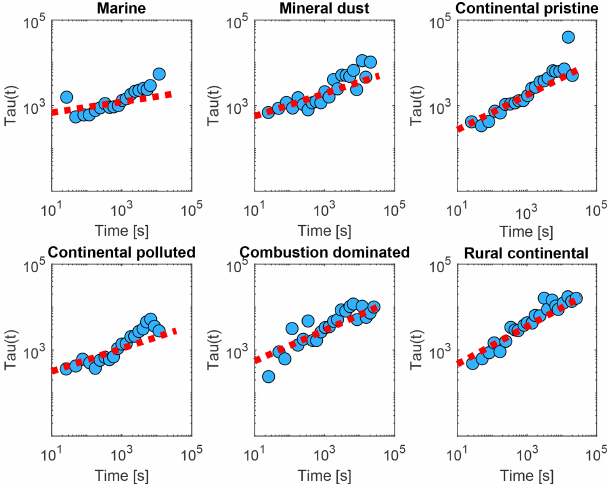
Figure 12. The relaxation time τ inferred from the isothermal experiments (up to 10h) using the averaged data (yellow dots in Fig. 9), with Eq. (3) as a function of time since the start of the isothermal phase (blue dots) for the marine, mineral-dust- influenced, continental pristine, continental polluted, combustion- dominated and rural continental samples of aerosol material (panels from top left to lower right). Also shown are empirical fits for all measurements of each sample using Eq. (4) (red dotted